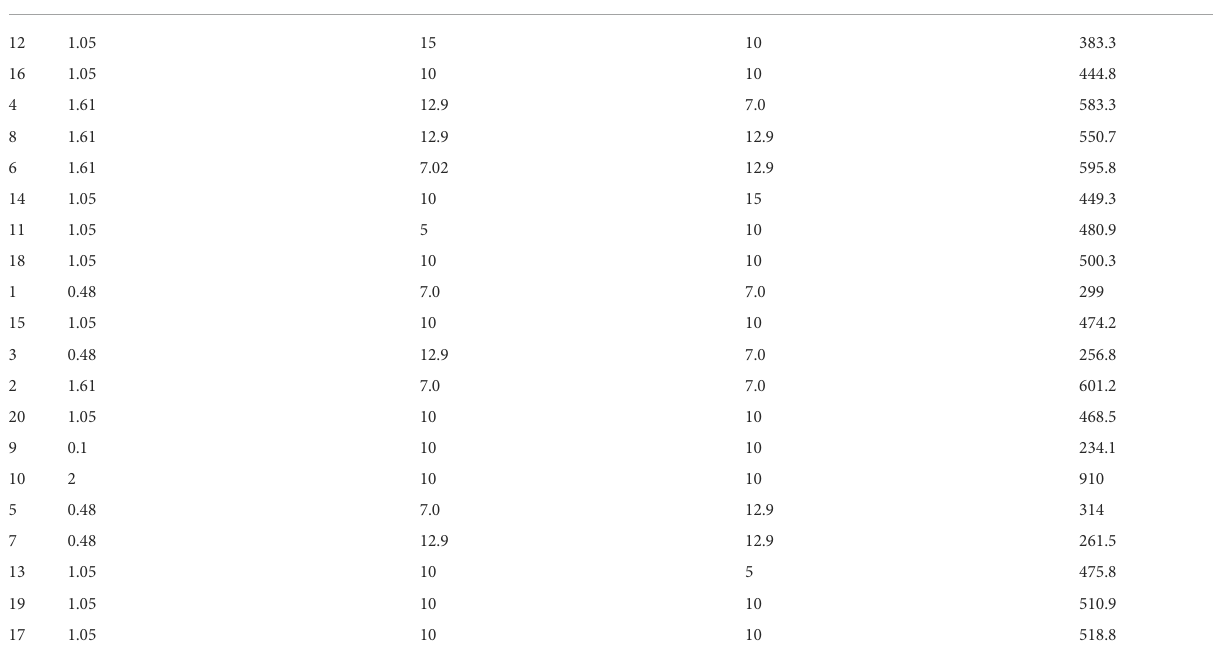
TABLE 1 Standard run order of the CCD experimental design given by the software with the mean particle size of Ru fi -NCs obtained in each